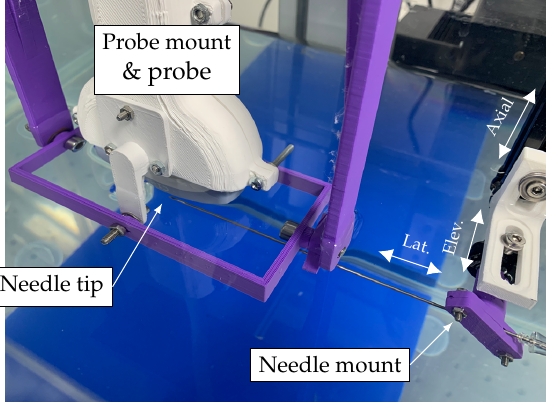
Figure 4. Photograph of the in vitro experimental setup showing the water tank containing the imaging probe and needle held in their mounts. The lateral, axial and elevational motion of the needle mount are indicated by white